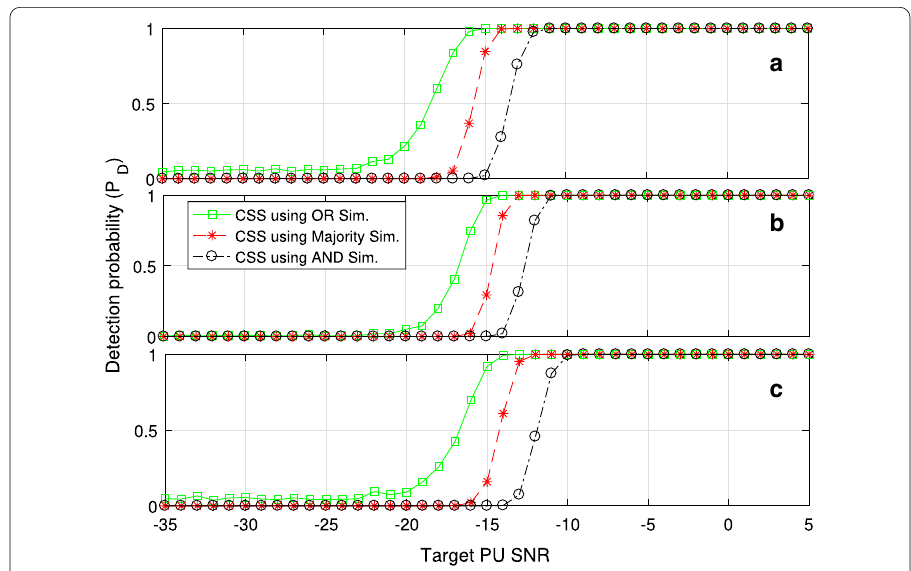
Fig. 8 CSS detection probabilities with a Max–Min ED, b Max/Min ED and c Diff. Max–Min ED and three different linear fusion rules for 2x-oversampled QPSK PU signal under Indoor channel and log-normal fading